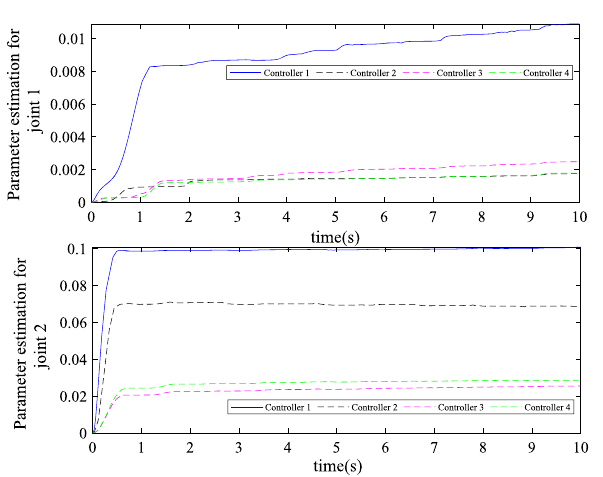
Fig. 5 Parameter v 2 estimation curve